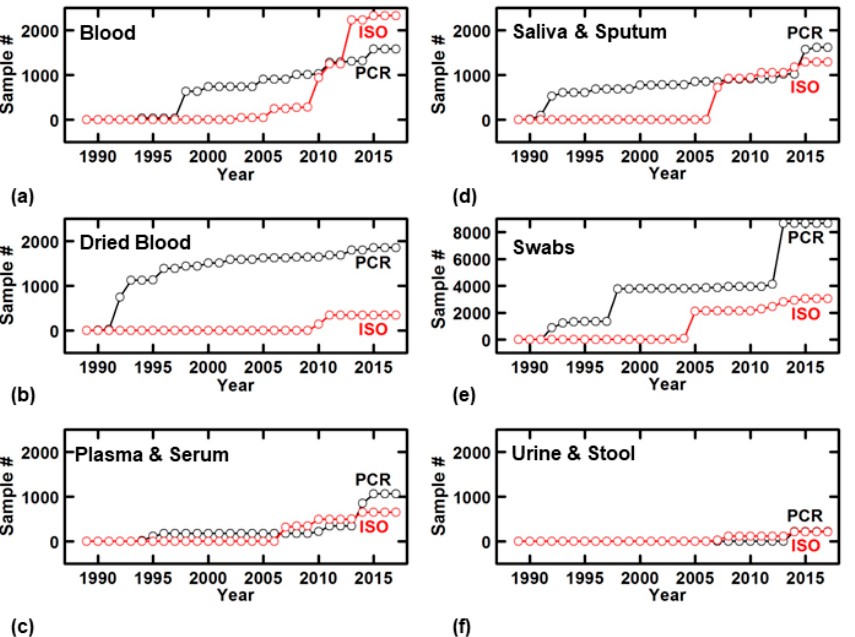
Figure 2. Time-series data for direct nucleic acid diagnostics according to accrued number of samples tested. Individual plots of number of clinical samples over time are subdivided according to sample matrix as follows: ( a ) whole blood, ( b ) dried blood, ( c ) plasma and serum, ( d ) saliva and sputum, ( e ) oral, dermal, and conjunctival swabs, and ( f ) urine and